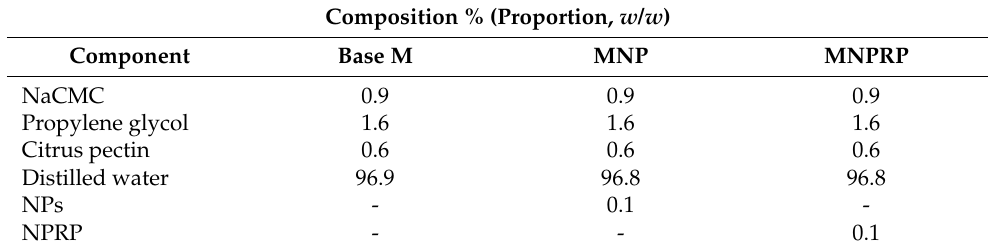
Table 1. Compositions of the membranes impregnated with nanoparticles. Composition % (Proportion, w / w )